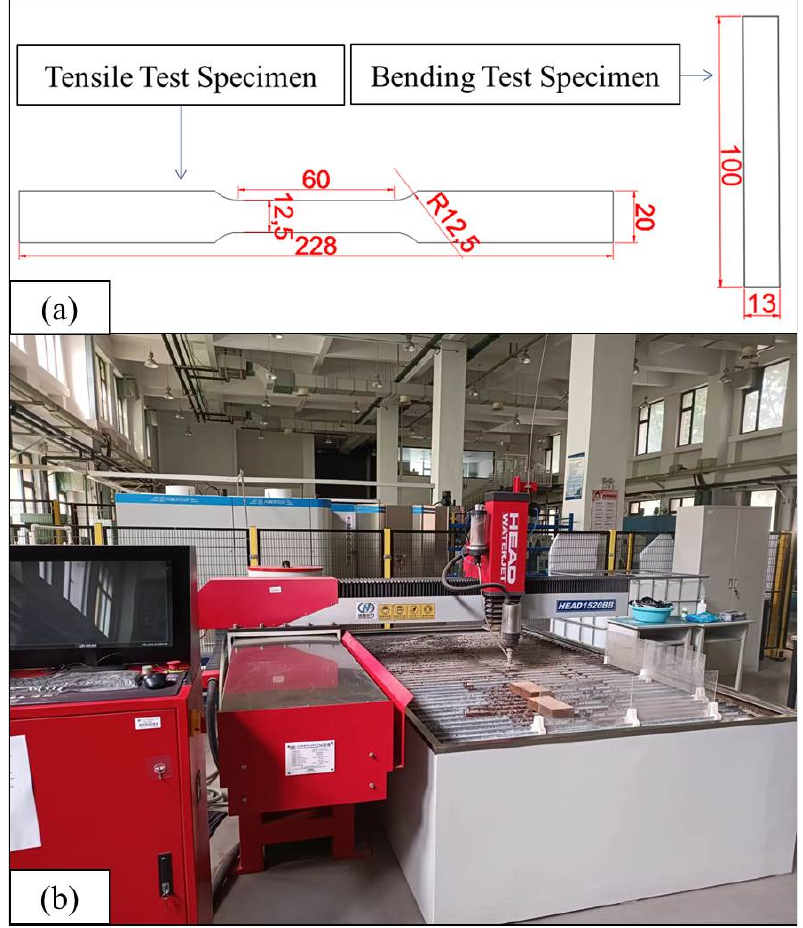
Figure 3. Sample size diagram and water jet cutting equipment ( a ) Schematic dimension of tensile and three-point bending test specimens ( b ) Water jet cutting equipment.